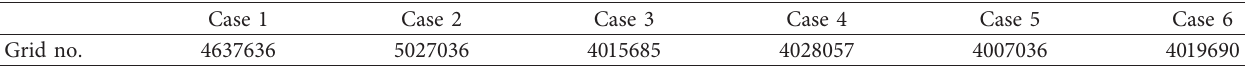
Table 6: The total grid number of six numerical